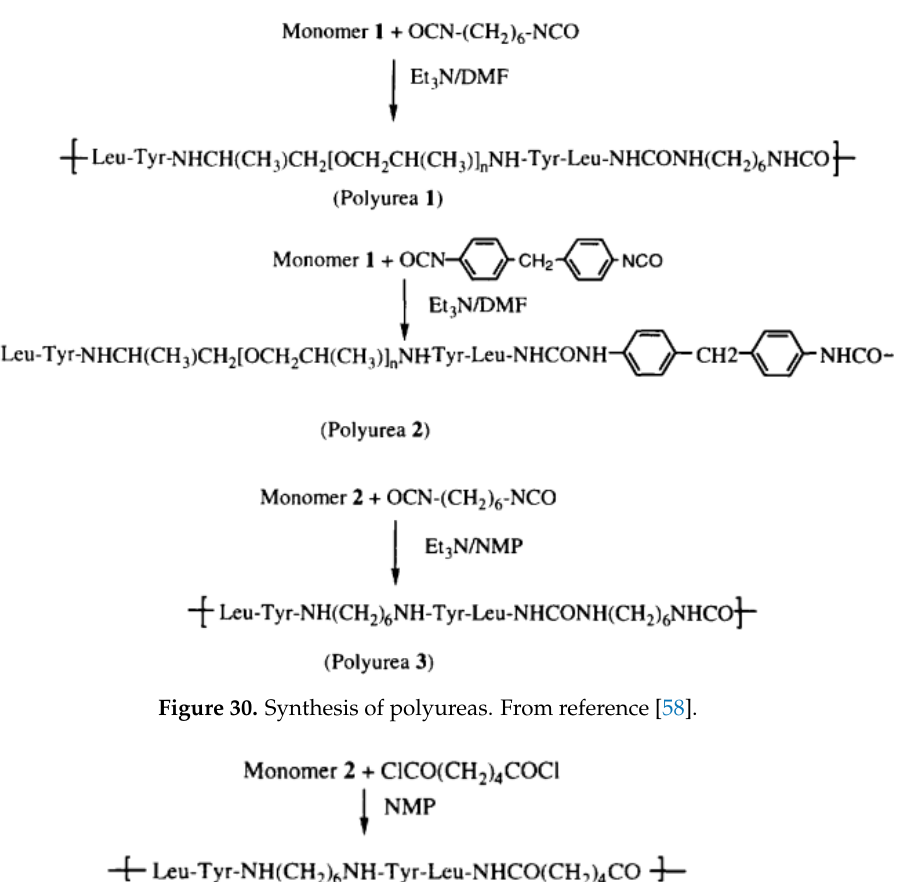
Figure 31. Synthesis of polyamides. From reference [58].